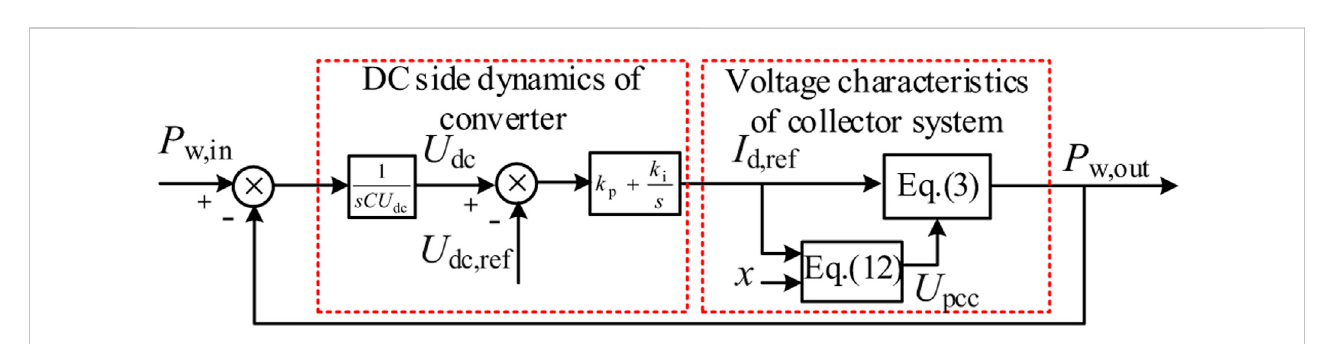
FIGURE 5 Power-Voltage characteristic transfer function block diagram of